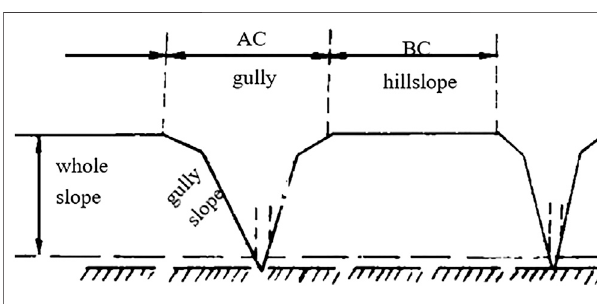
FIGURE 4 | Outline of the loess fl at highland